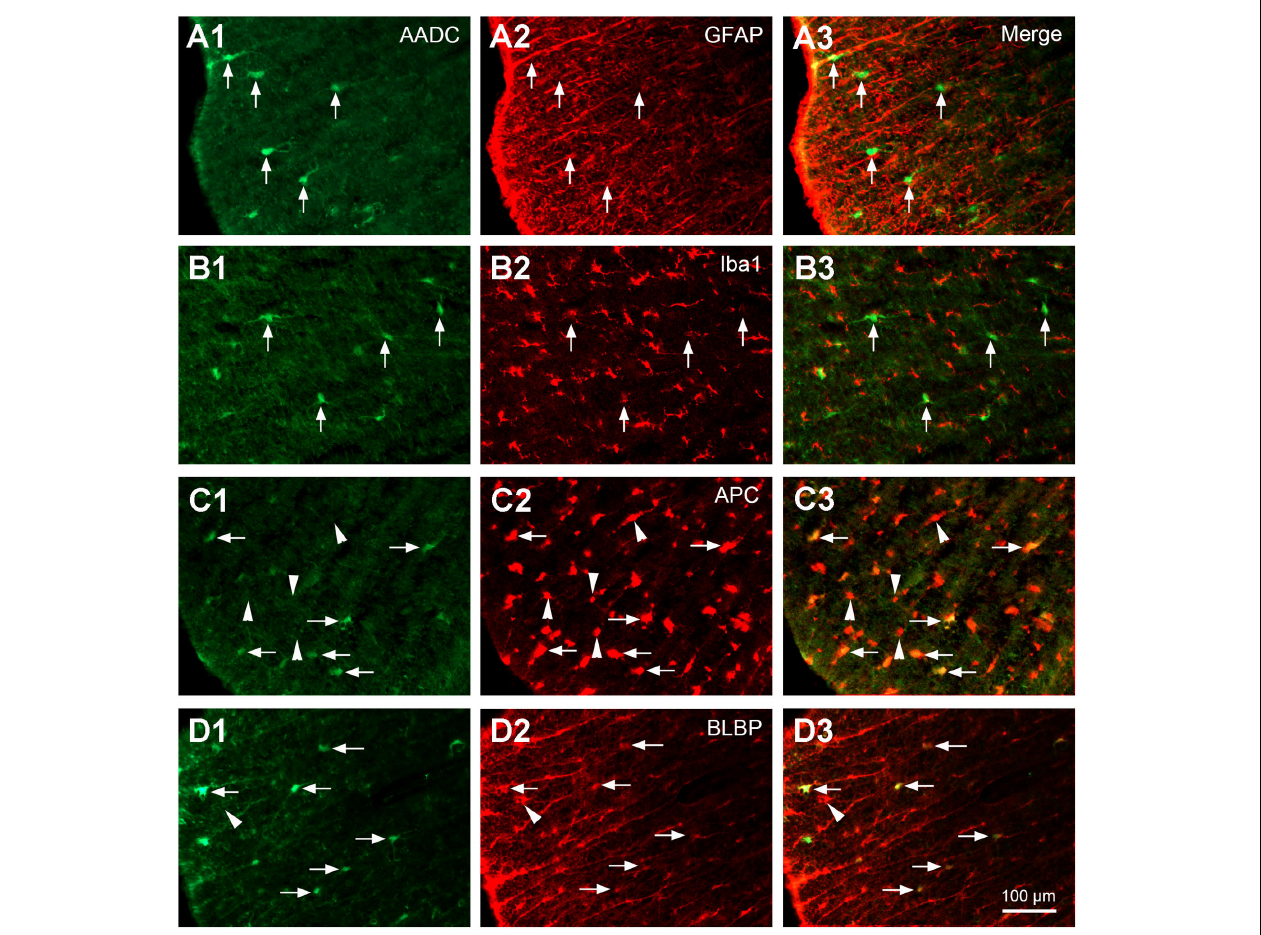
FIGURE 5 | Aromatic L -amino acid decarboxylase cells in the white matter expressed oligodendrocyte and radial glial phenotypes but not astroglial or microglial phenotypes. (A1–A3) AADC was not expressed in astrocytes immunolabeled with GFAP (arrows). (B1–B3) AADC was not expressed in microglia immunolabeled with Iba1 (arrows). (C1–C3) AADC was expressed in a small proportion of oligodendrocytes immunolabeled with APC (arrows). Note that only the larger, but not the smaller, APC immunopositive cells (arrowheads) were double-labeled with AADC. (D1–D3) AADC was expressed in radial glial cells immunolabeled with BLBP (arrows). Still not all BLBP-immunolabeled cells were AADC-IR (e.g., marked by an arrowhead). AADC antibody was from rabbit for (A1–C3) , from sheep for (D1–D3) . All the images were from transverse sections of thoracic (T) segments. Scale bar in (D3) , valid for all panels, 100 µ